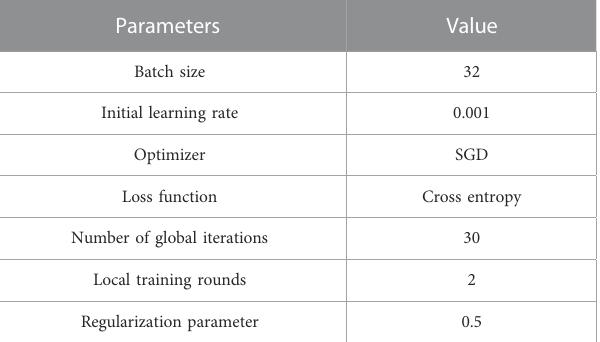
TABLE 2 The parameters used in federated and transfer